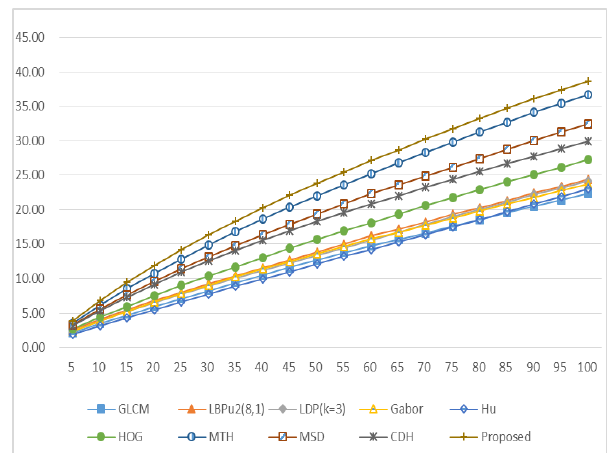
Fig.4. The average recall with different number of returned